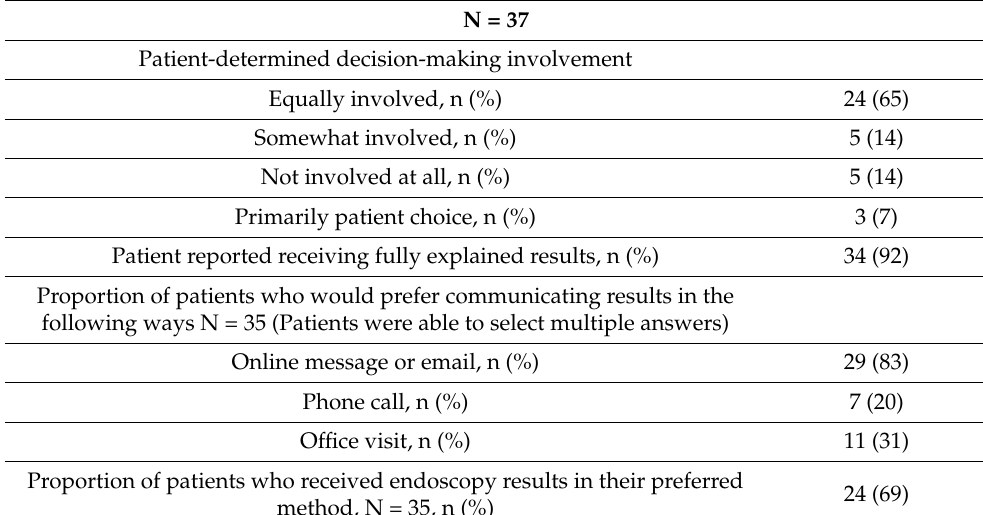
Table 3. Effectiveness of the patient–provider Communication. N = 37 Patient-determined decision-making involvement Equally involved, n (%) 24 (65) Somewhat involved, n (%) 5 (14) Not involved at all, n (%) 5 (14) Primarily patient choice, n (%) 3 (7) Patient reported receiving fully explained results, n (%) 34 (92) Proportion of patients who would prefer communicating results in the following ways N = 35 (Patients were able to select multiple answers) Online message or email, n (%) 29 (83) Phone call, n (%) 7 (20) Office visit, n (%) 11 (31) Proportion of patients who received endoscopy results in their preferred 24 method, N = 35, n (%)